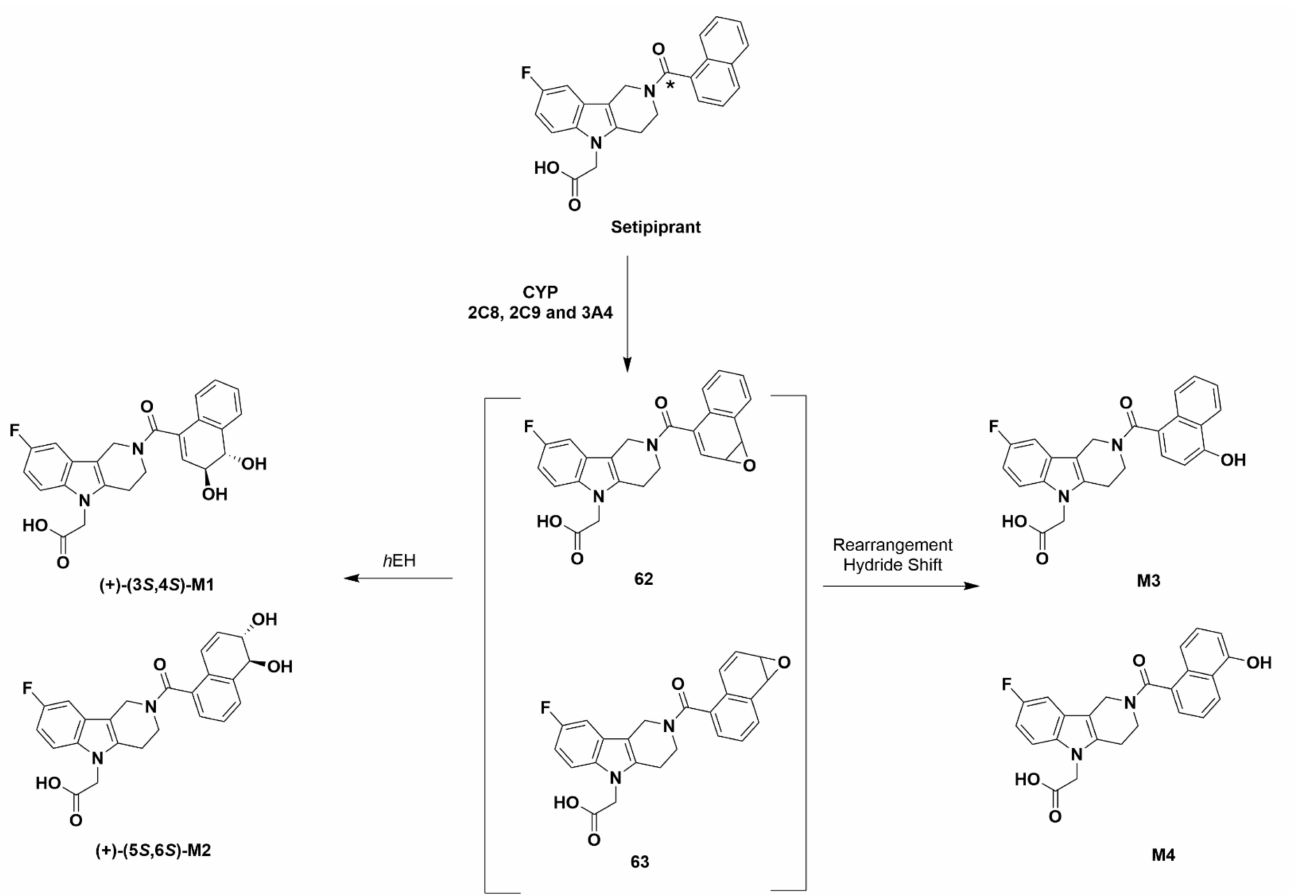
Figure 14. Metabolites of setipiprant [83]. The asterisk (*) denotes the position of the 14 C atom in [ 14 C]setipiprant